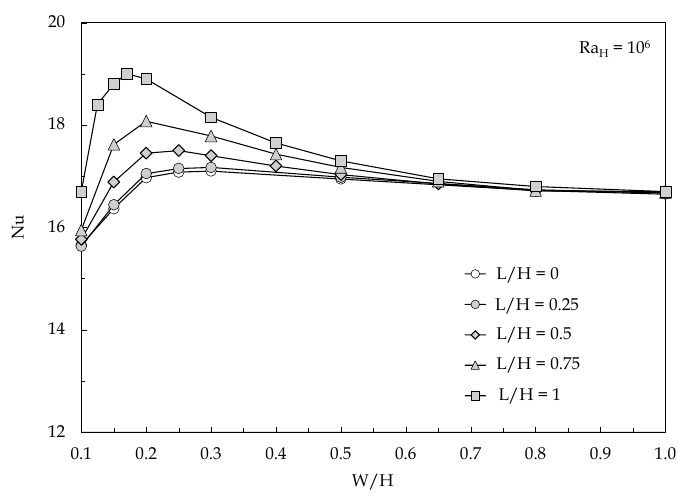
Figure 11. Nu vs. W / H for Ra H = 10 6 using L / H as the